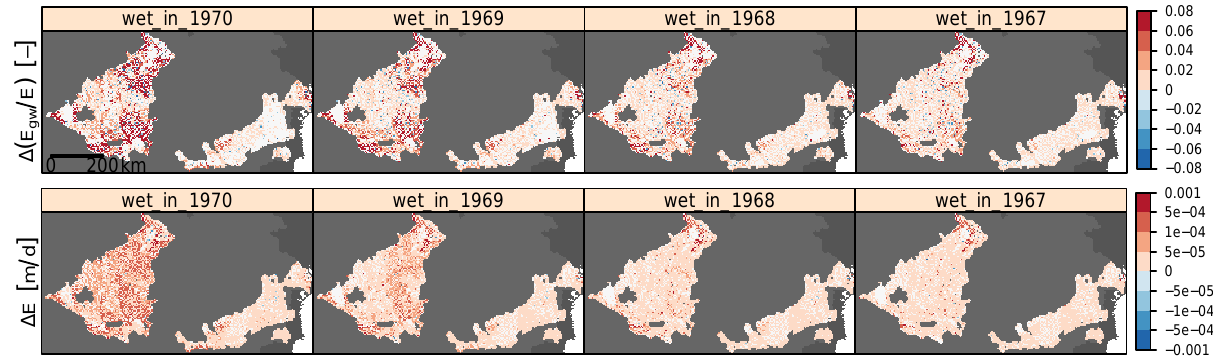
Fig. 7. Temporal persistence of summer evaporation and groundwater contribution to summer evaporation. Shown here is the difference in evaporation 1E and the difference in groundwater contribution to evaporation 1(E gw /E) in a dry summer (1971) after 10 yr of cyclic median climate forcing, compared to the same forcing except supplemented with a wet anomaly in the year just before (wet in 1970), two years before (wet in 1969),